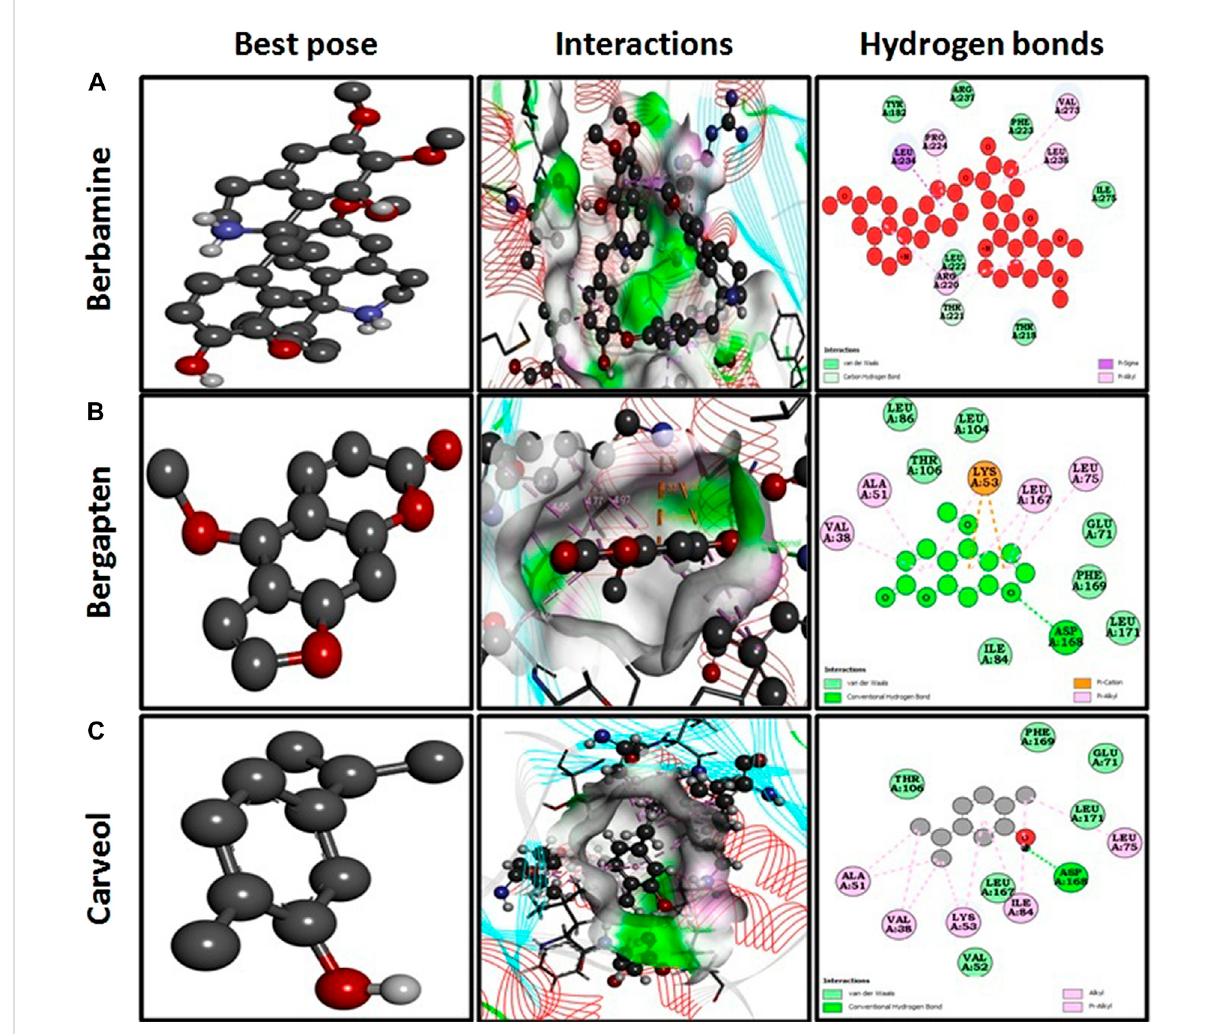
FIGURE 2 Represents best pose, interactions, and hydrogen bonds of berbamine (A) , bergapten (B) and carveol (C) and pregabalin against mitogenactivated protein kinase (MAPK, PDB I.D: 5UOJ) obtained through DSV